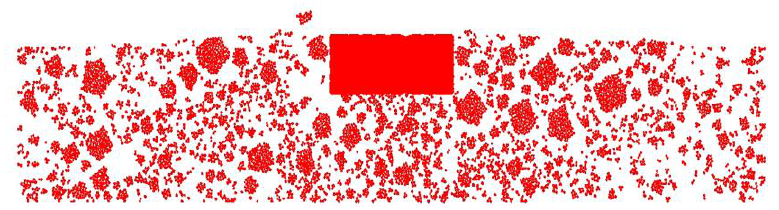
Figure 11. Coarse aggregate distribution after loading.